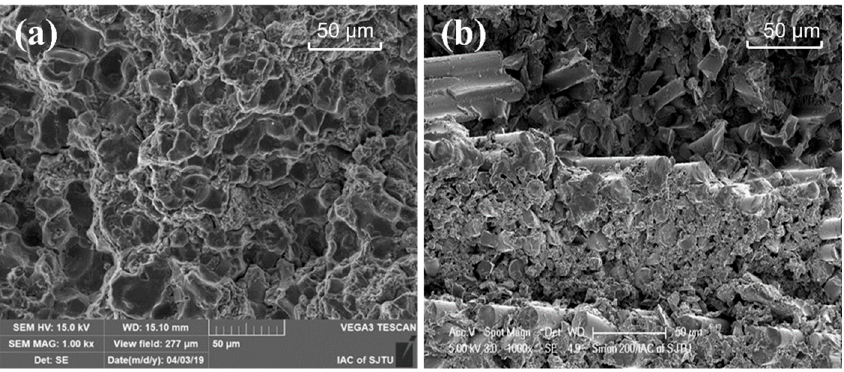
Figure 13. Scanning electron microscope (SEM) micrographs of GFRC laminates, ( a ) before lightning striking, ( b ) after lightning striking.